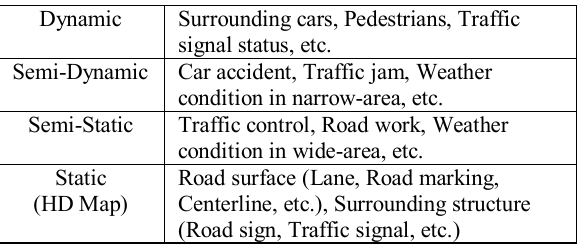
Table 2. Four layers of dynamic map